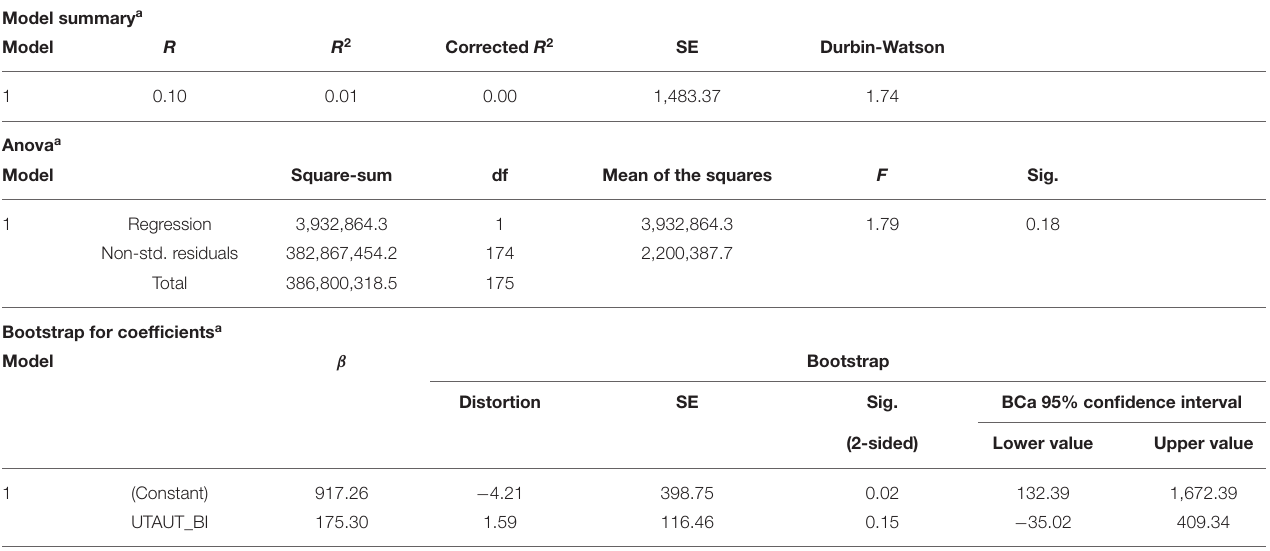
TABLE 8 | Influence of behavioral intention on willingness to pay.